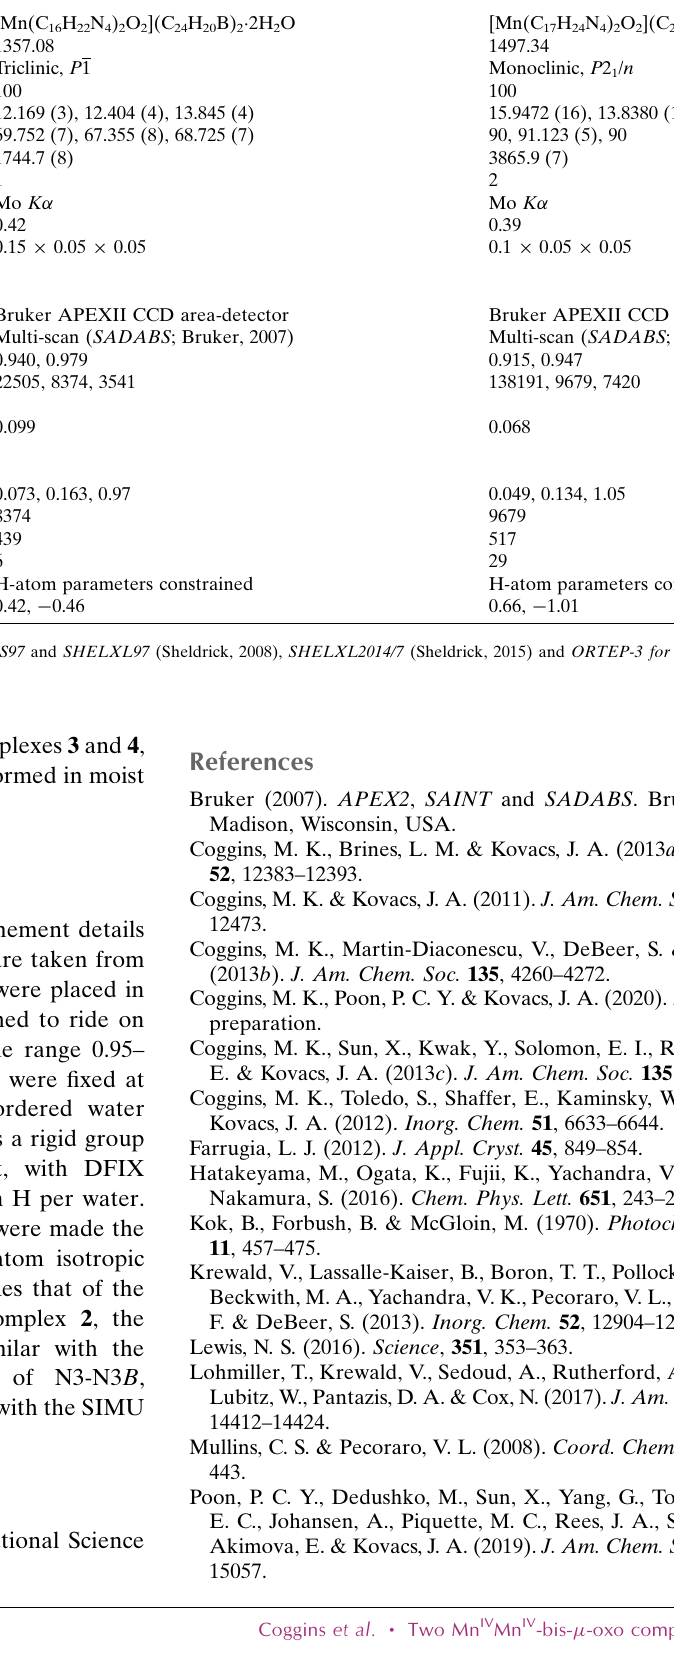
Table 2 Experimental details. Crystal data Chemical